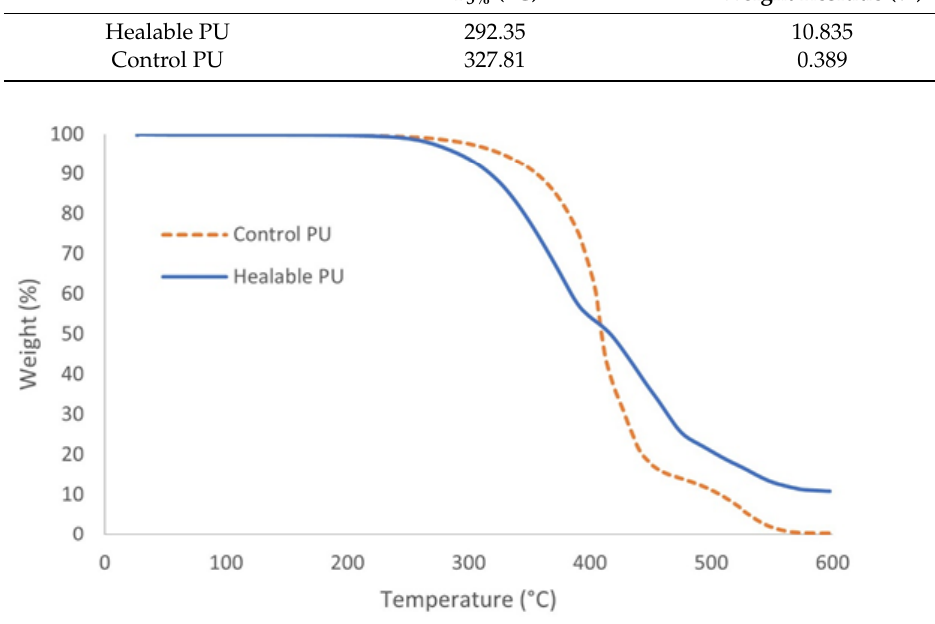
Figure 6. TGA curves of bio-based 2K PU coatings in air.